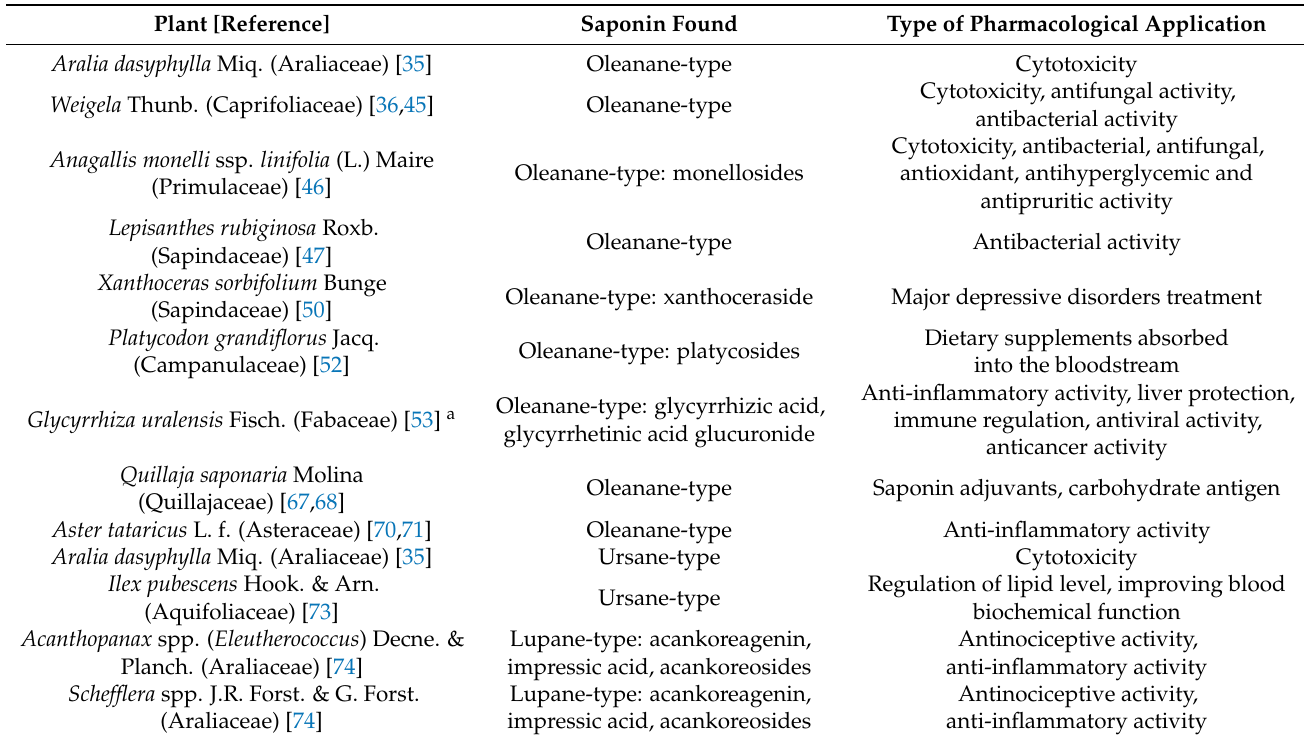
Table 4. Summary of the reviewed triterpenoid